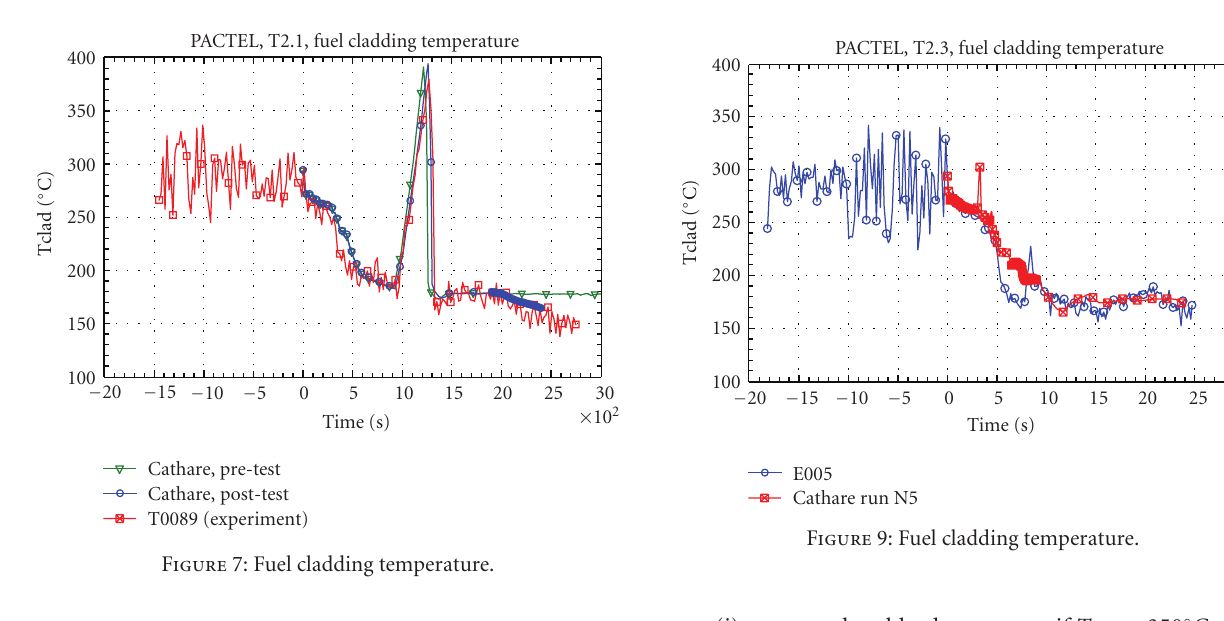
Figure 6: Void fractions (core upper half part).